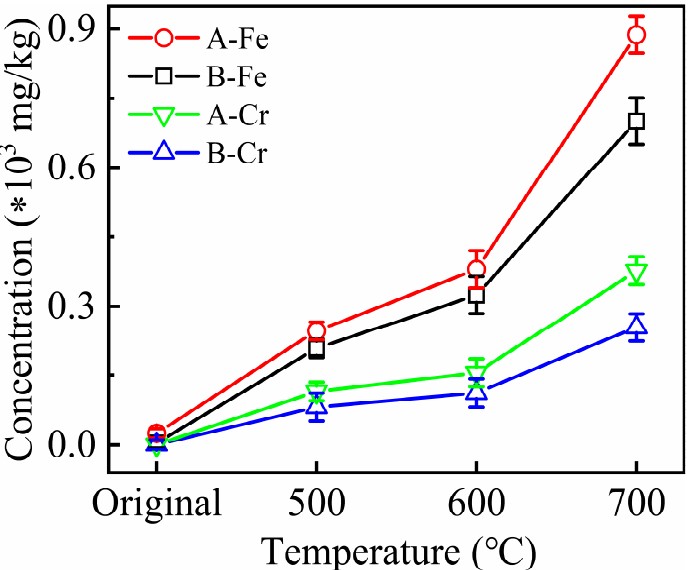
Figure 8. Concentrations of dissolved Cr and Fe elements in the post-corrosion salts A and B at different temperatures for 100 h.